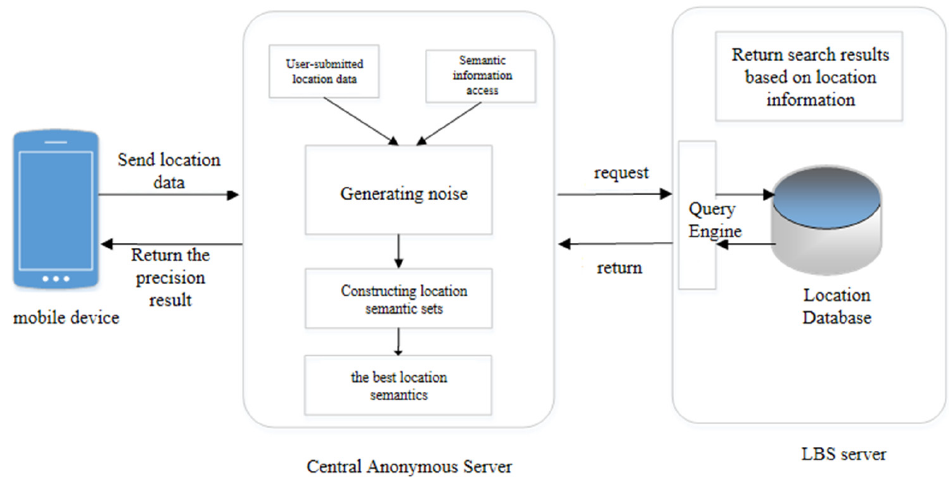
Figure 2. The system architecture of the DP protection method with location semantics.